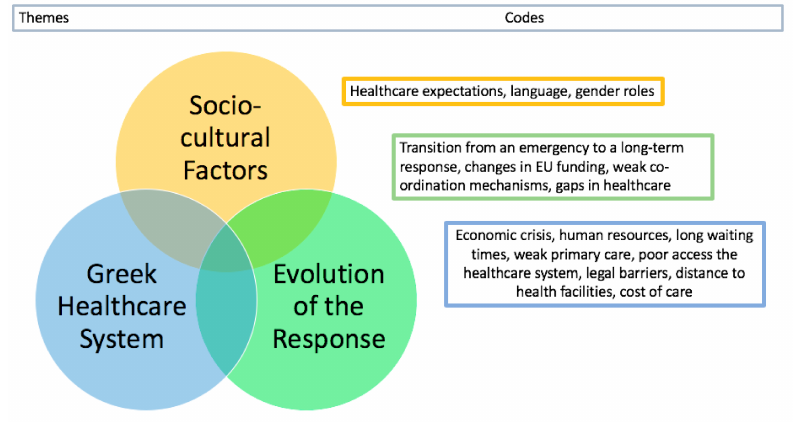
Figure 1. Main themes and codes emerging from analysis of key informants